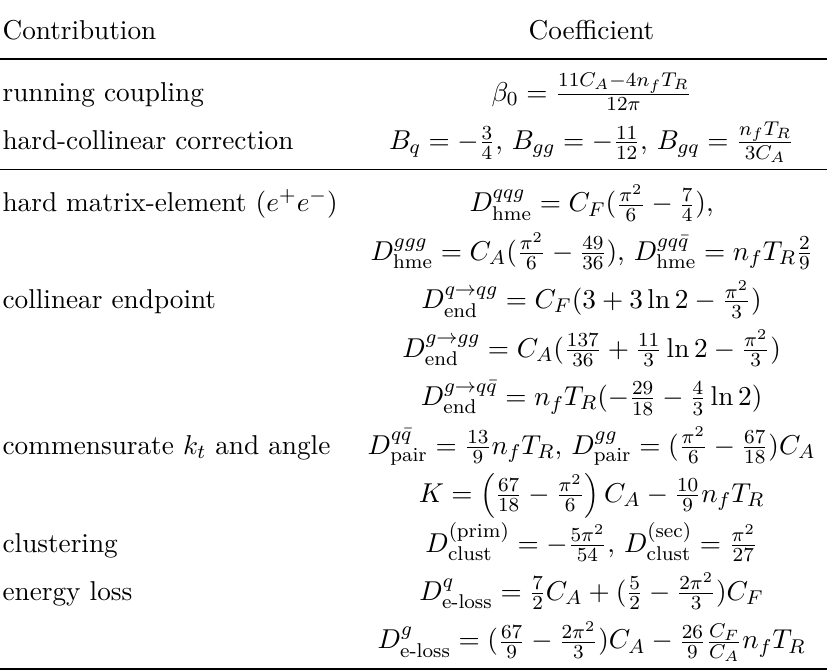
(top entries) and NNDL h 2 ,e + e −